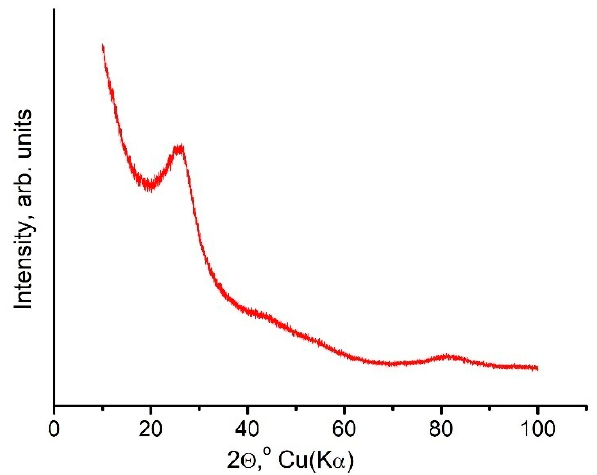
Figure 1. The X-ray diffraction pattern of the starting g -C 3 N 4 material.